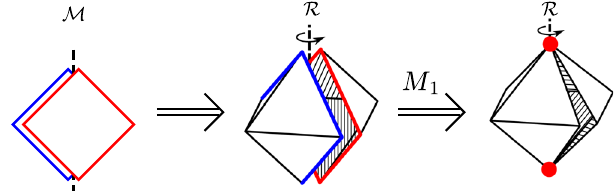
FIG. 8. Two copies of a topologically nontrivial superconductor in class DIII that are related by mirror symmetry M form a separable topological phase (left). The separable phase can be deformed into a hollow shell, such that the mirror symmetry M becomes a twofold rotation symmetry R (center). Upon addition of a mass term along the “ seams ” of the shell, while preserving the global twofold rotation symmetry, any pairs of counter- propagating Majorana hinge modes can be gapped out, leaving behind Kramers pairs of zero-energy states at the two corners on the rotation axis